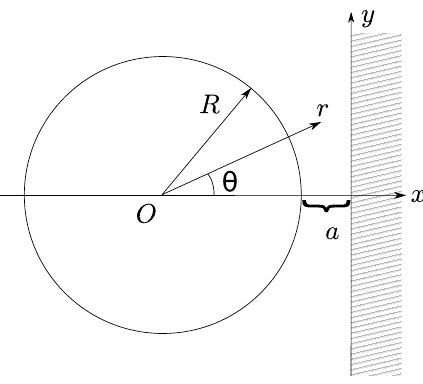
Figure 11 . Coordinate system ( r, θ ) for perturbation of the two N = 2 baby Skyrmions sitting side-by-side. Boundary conditions need to be imposed at O and at the compacton boundary r = R as well as at x = 0 (at re iθ = R + a + iy ) for attaining the ability of gluing the two solitons together.